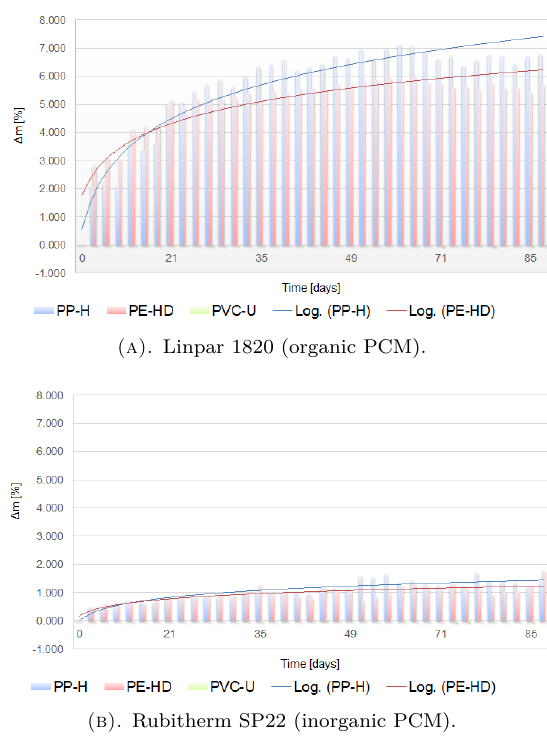
Figure 3. Comparison of the dependence of ∆ m value (in %) of plastics in two types of